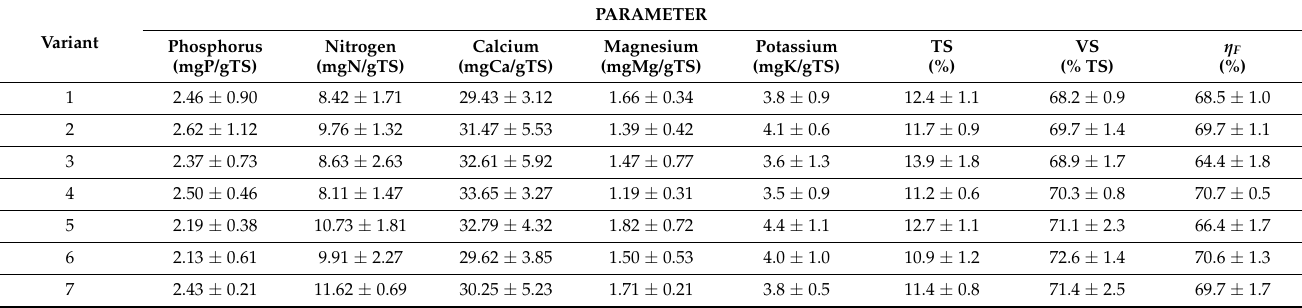
Figure 5. Correlations between ( a ) toxicity and portion digested, ( b ) portion digested and specific biogas/CH 4 production.